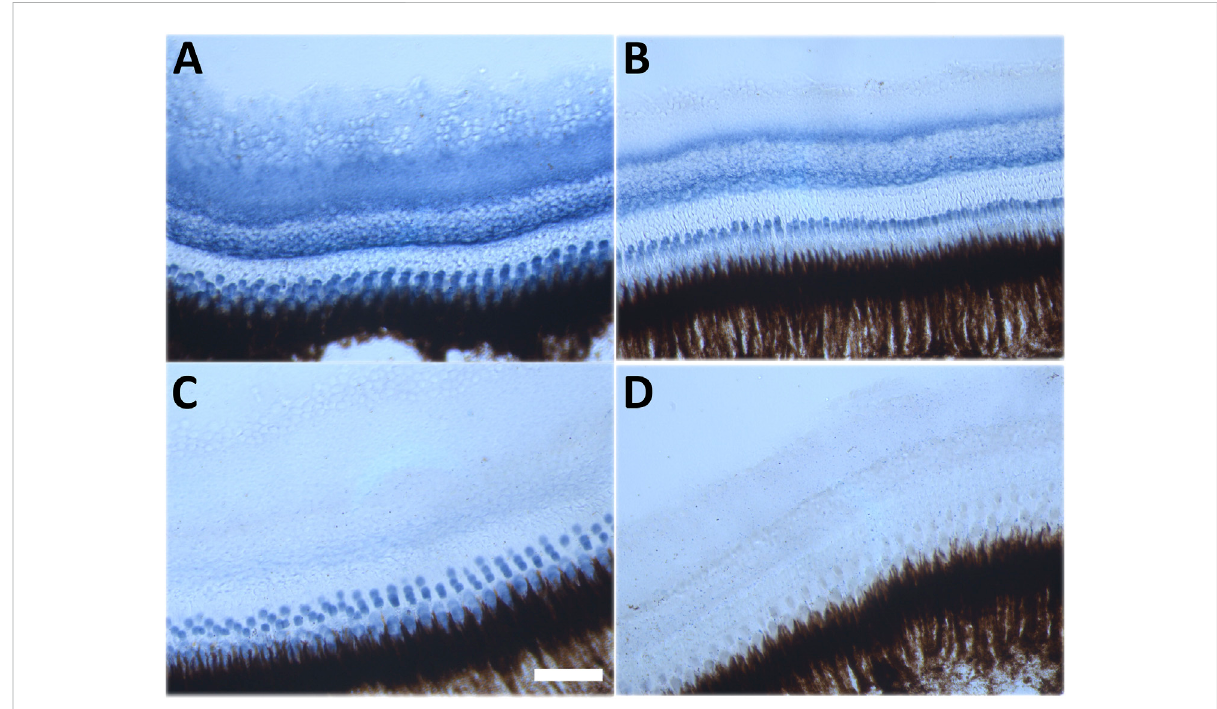
Histochemical detection of NQO1 enzyme activity in the adult zebra fi sh retina. Representative images of NQO1 enzyme activity in the adult zebra fi sh retina. Retinal cryosections of adult zebra fi sh were exposed to 100 μ M menadione, 1 mM NADPH, 100 μ M NBT for 30 min at 37 ° C. The presence of NQO1 activity is indicated by a blue reaction product. (A) DMSO-treated, (B) CQ-treated (10 μ M), (C) Dic-treated (0.5 μ M), (D) CQ and Dic-treated (10 μ M and 0.5 μ M). All in-vivo treatments were carried out for 48 h except for the combination treatment where four out of